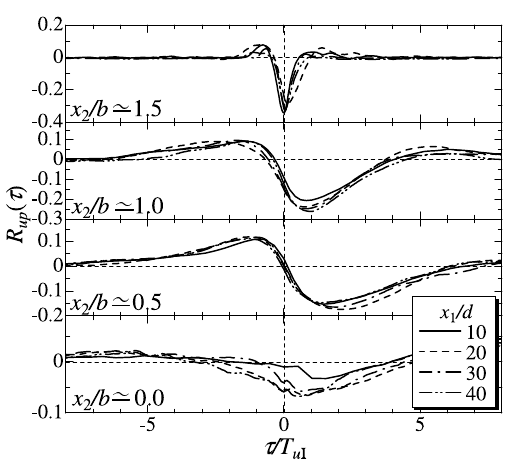
Fig. 19 Distribution of the cross-correlation coe ffi cient